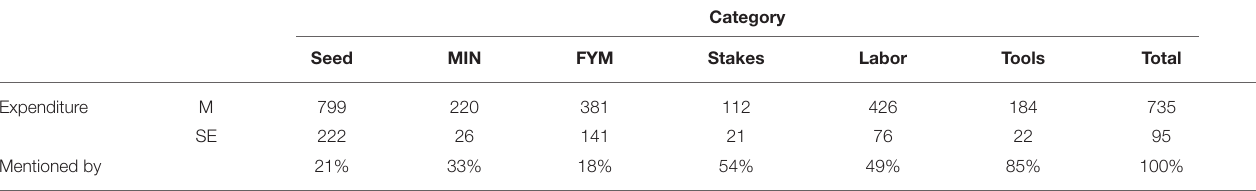
TABLE 2 | Annual expenditures (USD) for yam production per hectare.